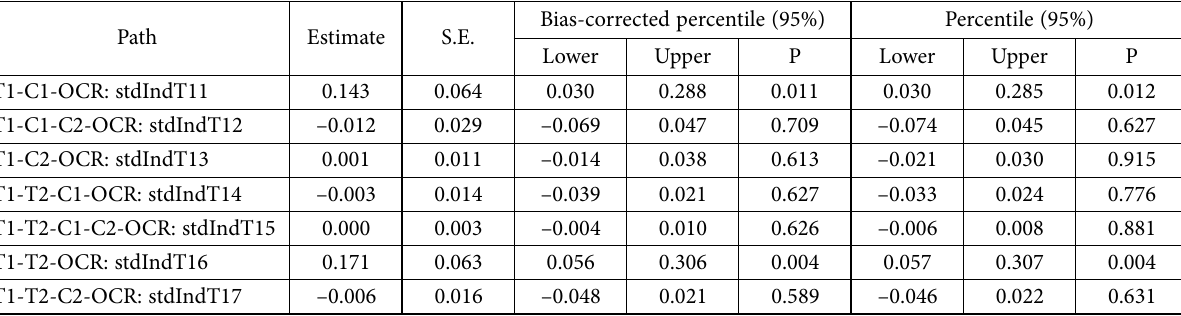
Figure 2. Results of the structural Table 9. Results of mediating relationships generated by bootstrap test